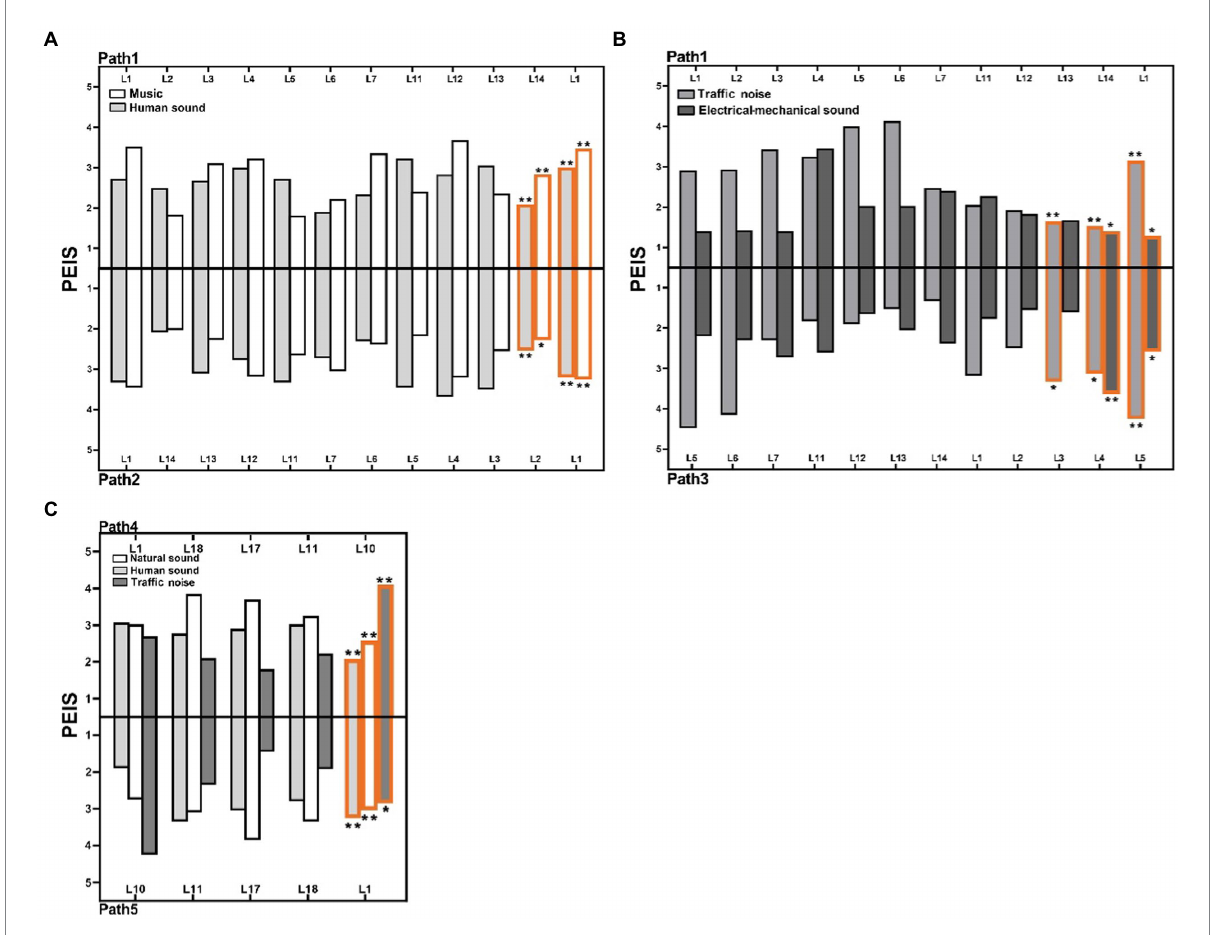
FIGURE 7 Comparison of PEIS, at each location, in paths with the differences in the overall PEIS: (A) Comparison of the perceived extent of human sound and music at each location in G1, (B) Comparison of perceived extent of traffic noise and electro-mechanical sounds at each location in G2, and (C) Comparison of perceived extent of traffic noise, human sound and natural sounds at each location in G3 (* p < 0.05, ** p < 0.01: Correlation between perceived extent of sounds of each location, and the overall perceived extent of sounds in